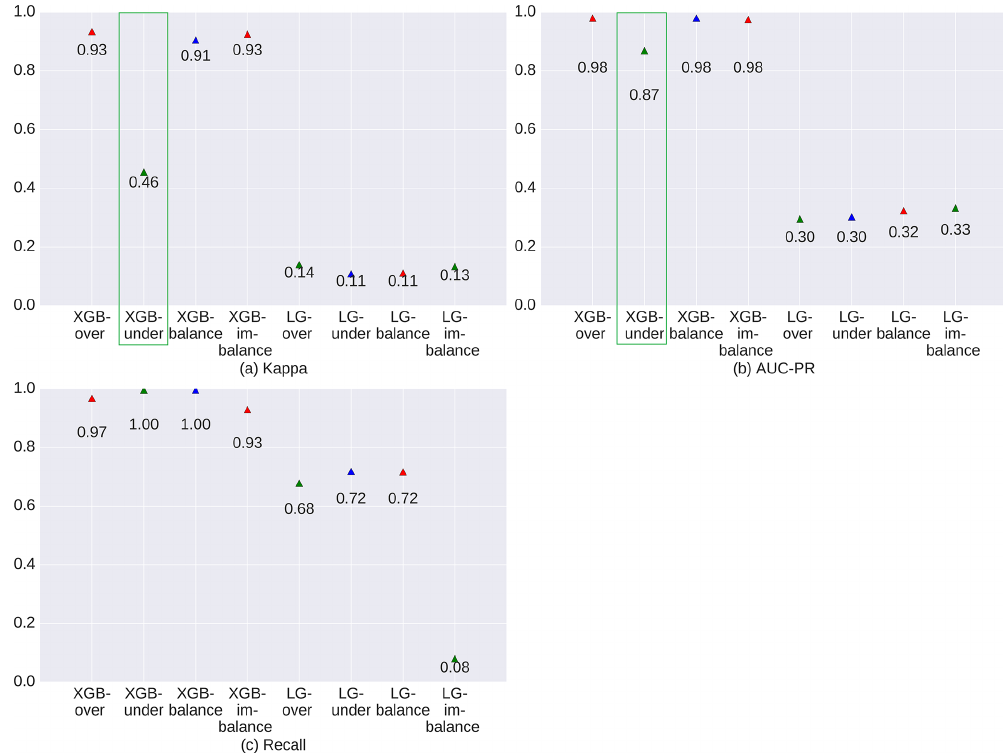
Figure 4. Evaluation of model performance during the prediction process for newly added grassland between 1975–2015.